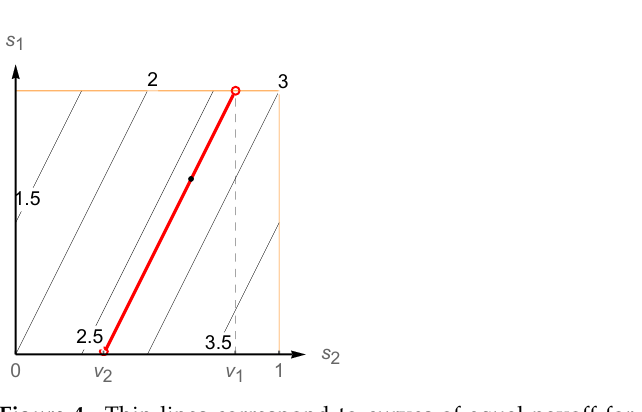
) . Here, S ( v ) coincides with the curve , 1 I 6 3 ) form a Nash equilibrium with the ESD ( 2 , 1 6 3